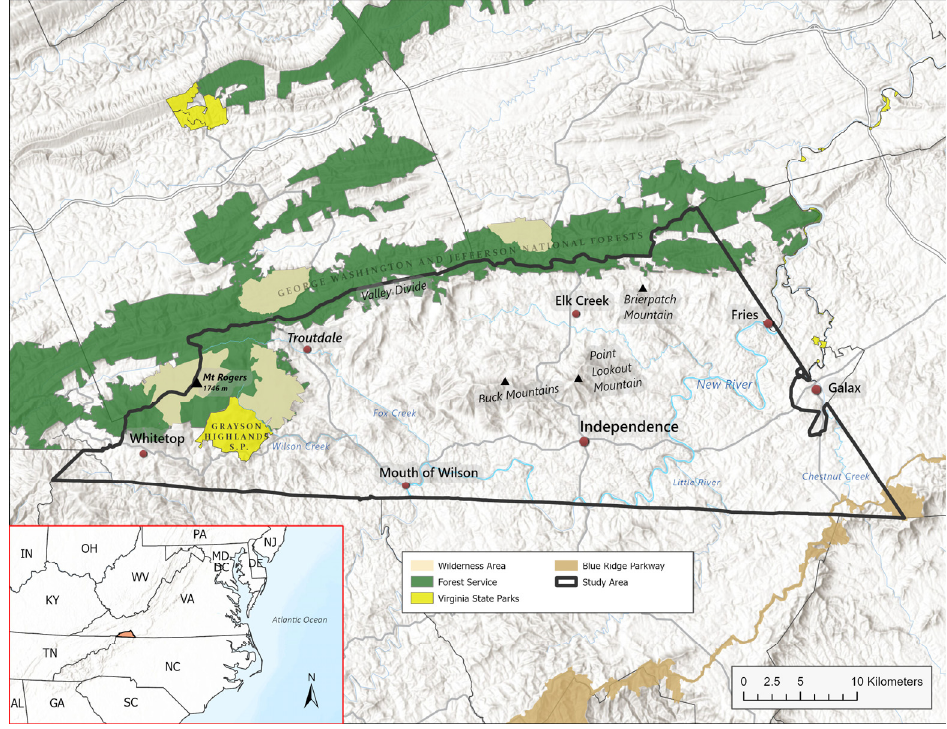
Figure 1. Grayson County, Virginia, U.S.A. Landmarks and designated public land. Wilderness Area is managed by the U.S. Department of Agriculture, Forest Service. The Blue Ridge Parkway is a scenic byway managed by the U.S. National Park Service.